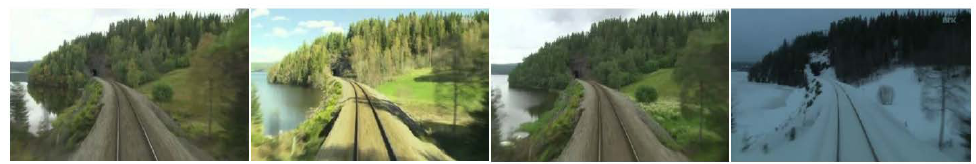
Figure 2. Frames extracted from the Nordland dataset [20] that are from the same place in spring, summer, fall, and